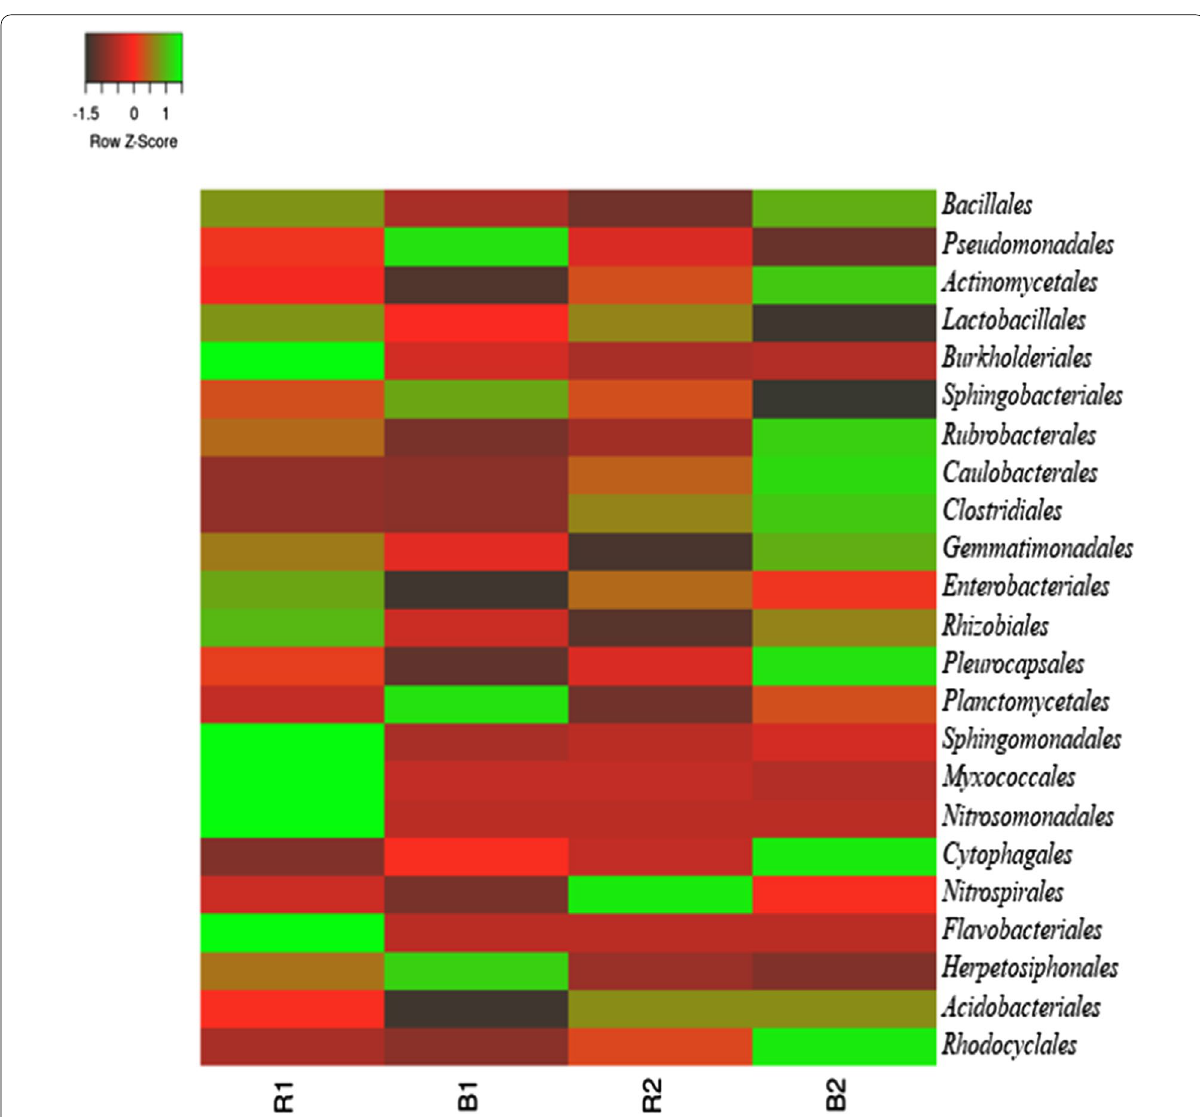
Fig. 4 Relative abundance of the bacterial taxonomic structure at order level from sunflower rhizosphere and bulk soils. Bacterial groups with high colour intensity have higher relative abundant values. R1 Ditsobottla rhizosphere soil; B1 Ditsobottla bulk soil; R2 Kraaipan rhizosphere soil; B2 Kraaipan bulk